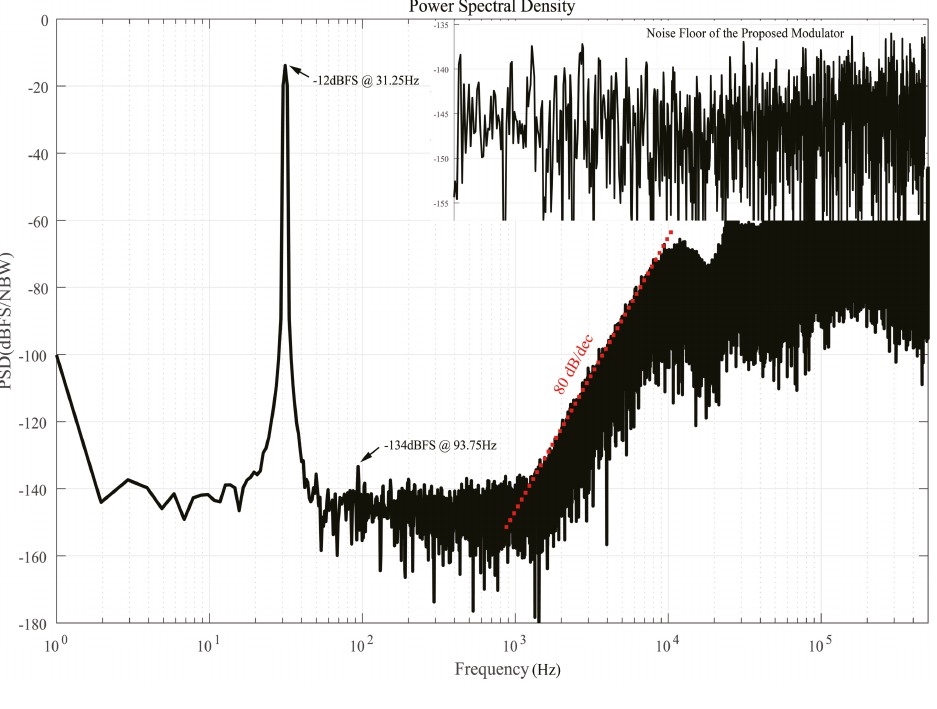
Figure 16. Measured modulator output spectrum.